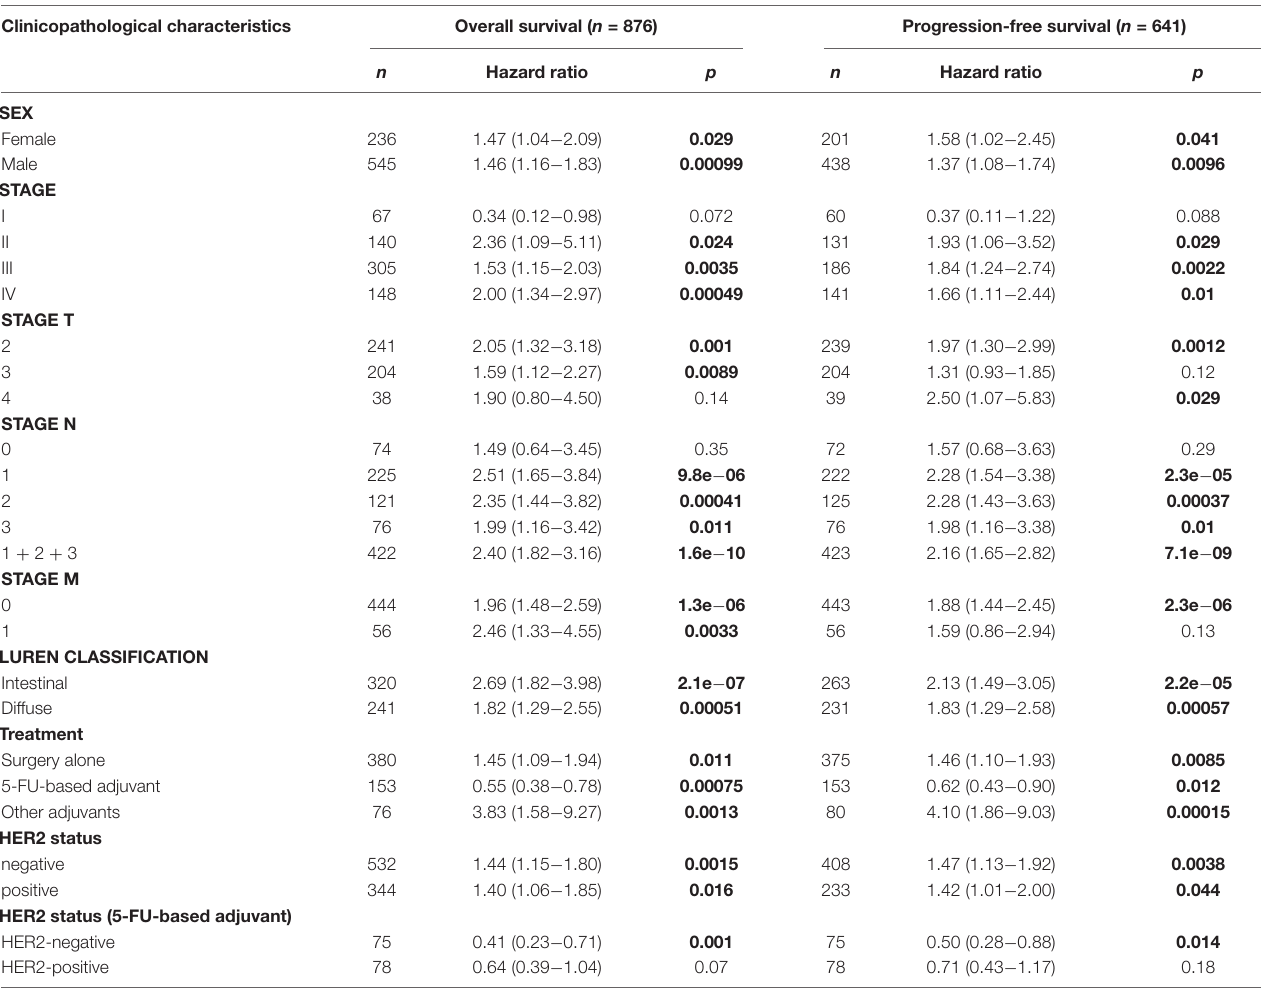
TABLE 1 | Correlation of NNMT expression and prognosis in gastric cancer with various clinicopathological factors. Clinicopathological